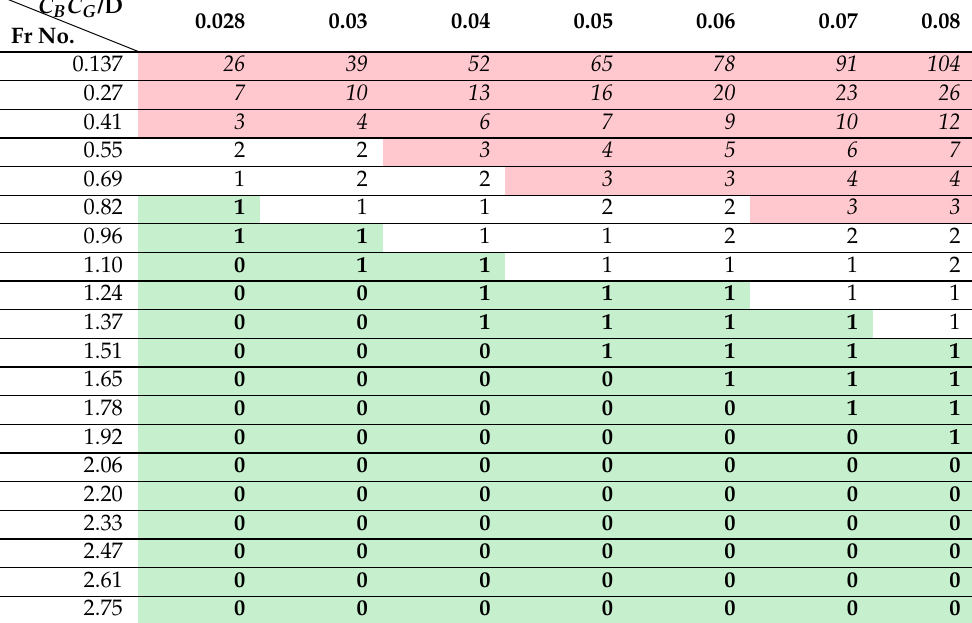
Table 3. Ratio ( G Vgrav − G V )/ G V ) is an expressed percent to indicate the significance of the new index with respect to speed and C B C G separation. The first column is forward speed non-dimensionalized as Froude number; the first row is C B C G non-dimensionalized with craft diameter. The green areas (bold font) are applicable for the assumption of high speed, i.e., these areas have negligible difference if gravity is considered. The white areas (regular font) can go either way depending on required accuracy of linear dynamic stability. The red areas (italic font) are recommended for the implementation of G Vgrav . This implies that the inclusion of gravity has a significant effect on the value of stability index. The range of applicability would obviously change with the design of craft. These values are presented for the baseline design and shall apply to all the iterations presented. C B C G Fr No.